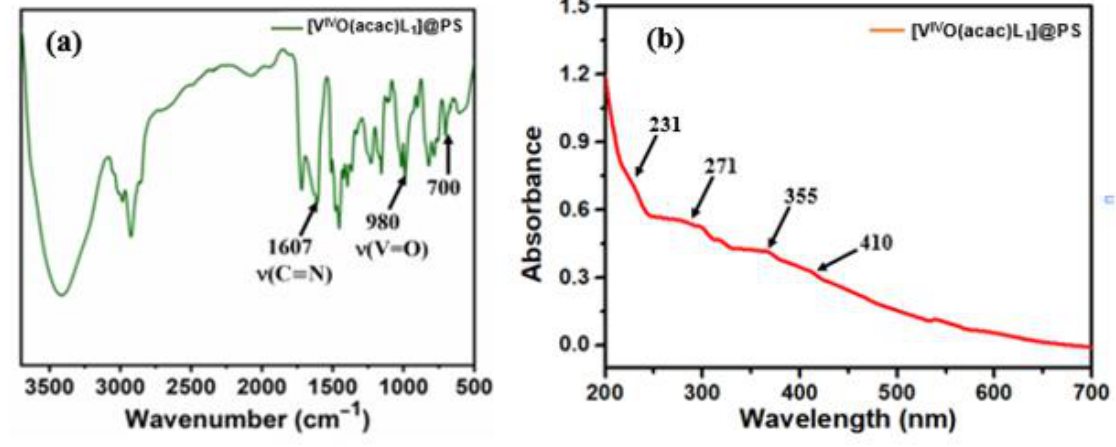
Figure 19. FT-IR spectrum ( a ) and UV-visible spectrum ( b ) of reused [V IV O(acac)L 1 ]@PS ( 3 ).